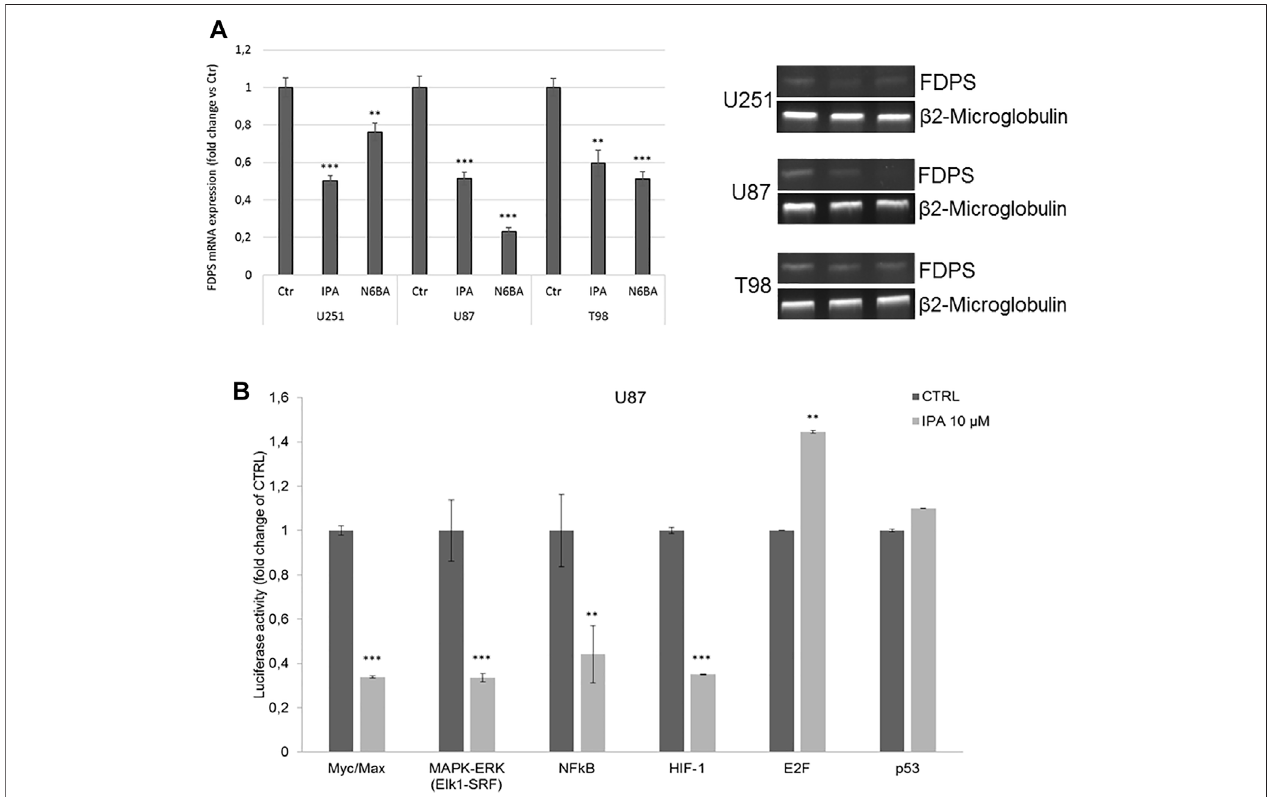
FIGURE 2 | IPA affects the transcriptional activity of FBXW7 substrates. (A) Representative FDPS mRNA expression (left panel) and densitometric analysis (right panel) in U251. U87 and T98 cells were treated with IPA 10 µM or N6-BA 10 μ M for 24 h. Data are expressed as mean ± SD of at least three independent experiments. ** p < 0.01, *** p < 0.005 vs. control. β 2-Microglobulin was used as a reference gene. (B) Luciferase activity on selected cancer-related Transcriptional Responsive Elements(TREs). Analysisofluciferase activity of TREs controlled byMyc, ERK, NFkB, HIF-1 α ,E2F, orp53 inthe U87 cell line. Thehistograms represent luciferase activitymeasuredat18 hfromtransfectionwithareporterconstructcontainingtheTREelementsandtreatedwithIPA10 μ Morvehicle.Fire fl yluciferasewasnormalized toRenillaluciferasereading,andthedatawereplottedasfoldchange(mean±SDoffourindependentexperimentsintriplicate;unpairedtwo-tailedStudent ’ st-test;** p < 0.01; *** p < 0.005) compared to control